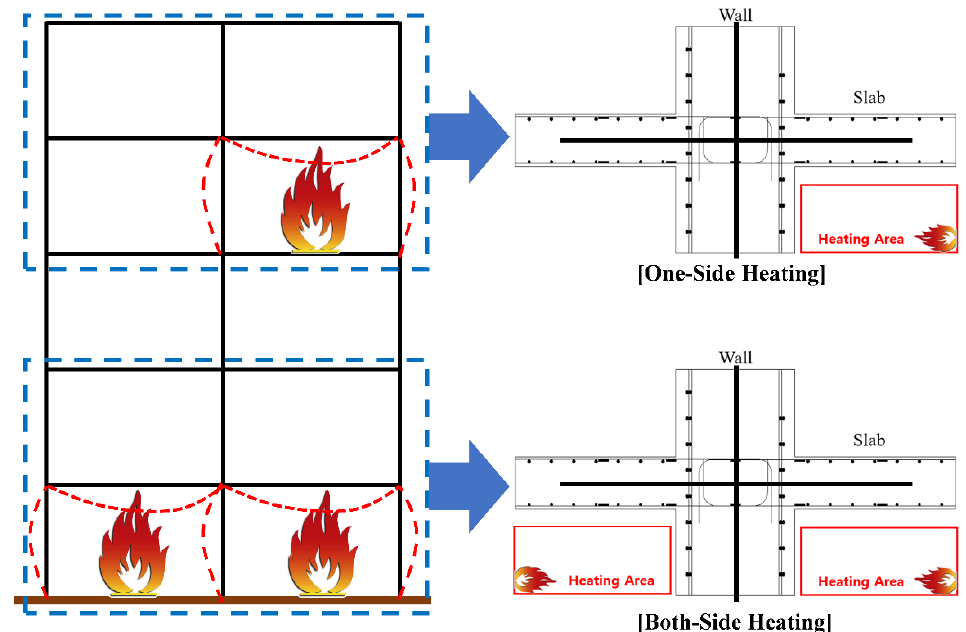
Figure 4. Concept of one-sided heating and two-sided heating. Table 3. Minimum dimensions and axis distances for load-bearing reinforced concrete walls (EN1992-1-2 [17]).